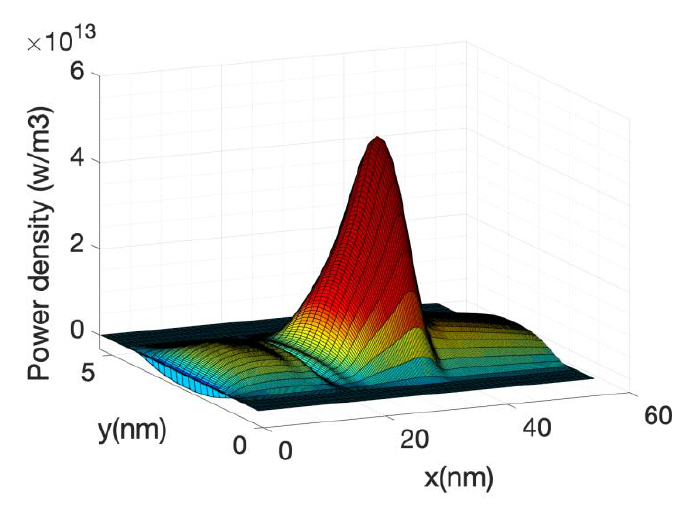
Figure 13. Heat source due to hot electrons system at Vg = 0.7 V.